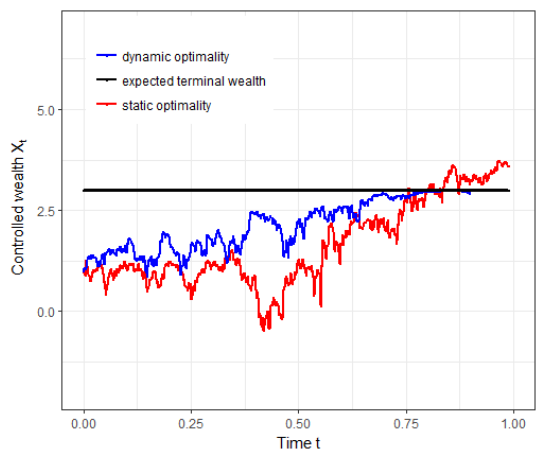
Figure 4. Trajectories of static and dynamic